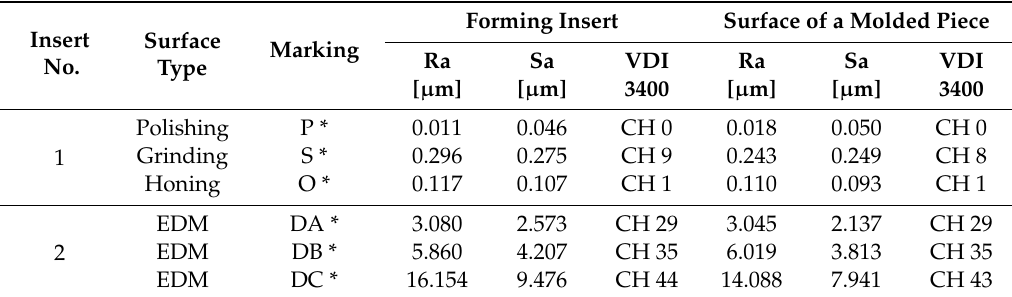
Table 3. Surface topography parameters (average values) for the adopted types of the surface finishing of injection molding cavities used in the research and for the molded parts obtained in these cavities. Samples of PP without the addition of laser marking additives (LMA) and a mold temperature of 20 ◦ C.